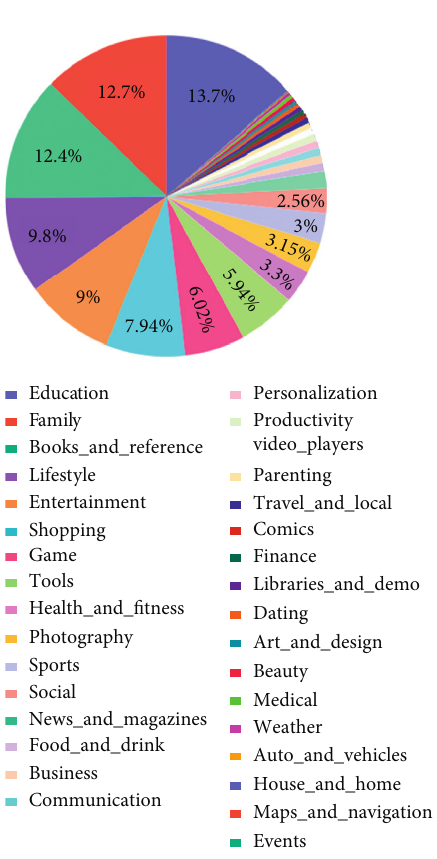
Figure 4: Number of installed Arabic apps per category in Google Play app